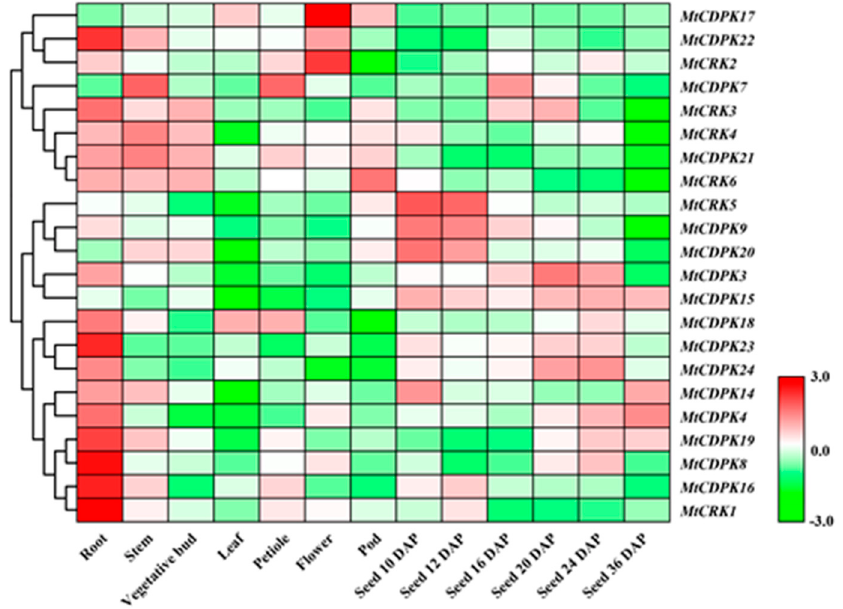
Figure 5. Expression patterns of MtCDPK and MtCRK genes in different developmental tissues. The microarray data were normalized based on the mean expression value of each gene in all organs analyzed. The heat map portrayed the relative expressions after log 2 transformed. The corresponding group of each gene was shown on the left. DAP, days after pollination.